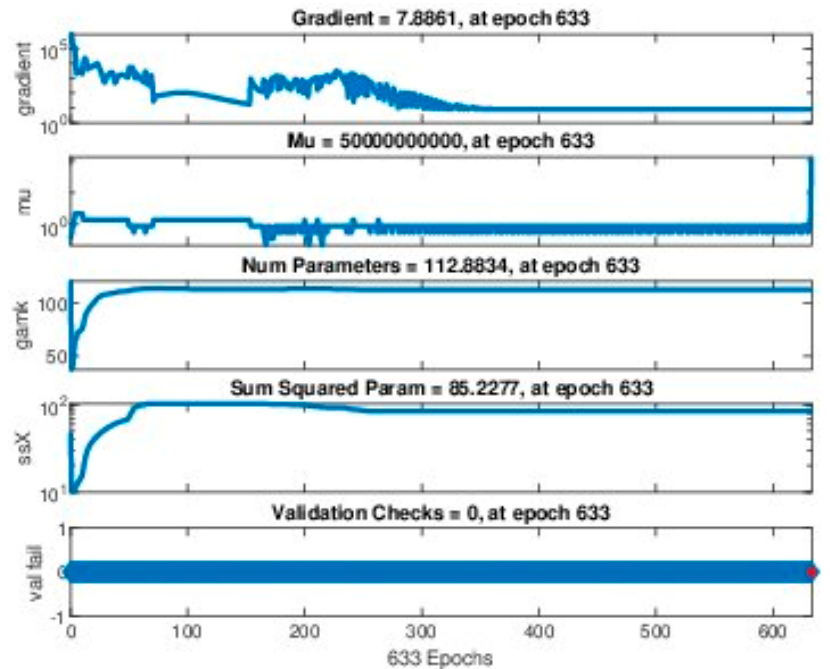
Figure 13. Various training states of neural network (solar irradiance forecasting case).